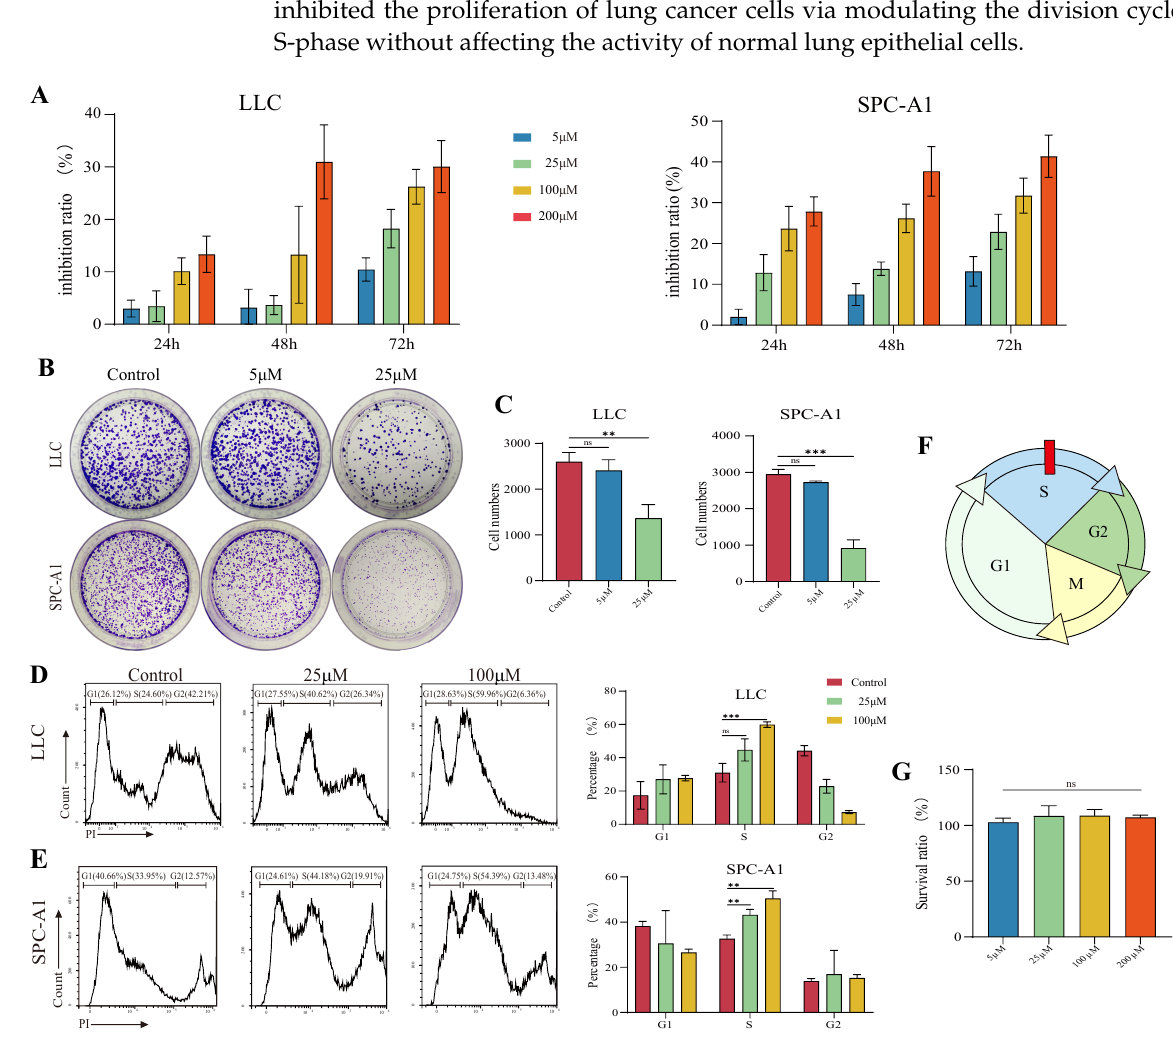
Figure 1. TAX inhibits tumor cell proliferation, arrests the cell cycle in the S-phase, and does not inhibit bronchial epithelial-like cell proliferation. ( A ) CCK-8 assay was carried out and the absorbance was measured at 450 nm, and cell viability calculated. ( B , C ) Crystal violet staining was performed to demonstrate the colony-formation ability, and cell counting was performed using Image J software. ( D , E ) The percentage of cells in each phase was obtained and statistically analyzed by flow cytometry using PI staining to label the DNA. ( F ) The cell cycle was arrested in the S-phase. ( G ) The viability of HBE cells treated with TAX was measured using the CCK-8 assay. ns, not significant, ** p < 0.01, *** p < 0.001. (Student’s t -test). Data are presented as mean ±